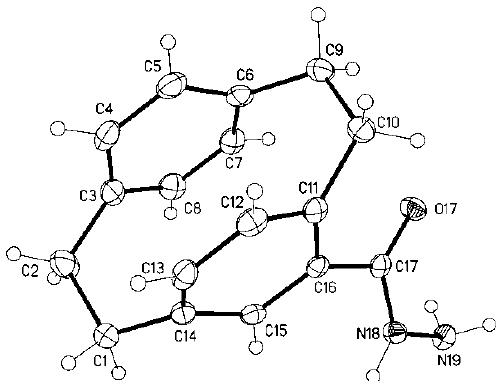
Figure 3. Molecular structure of compound 1 identified according to the IUPAC nomenclature as 1,4(1,4)-dibenzenacyclohexaphane-1 2 -carbohydrazide.